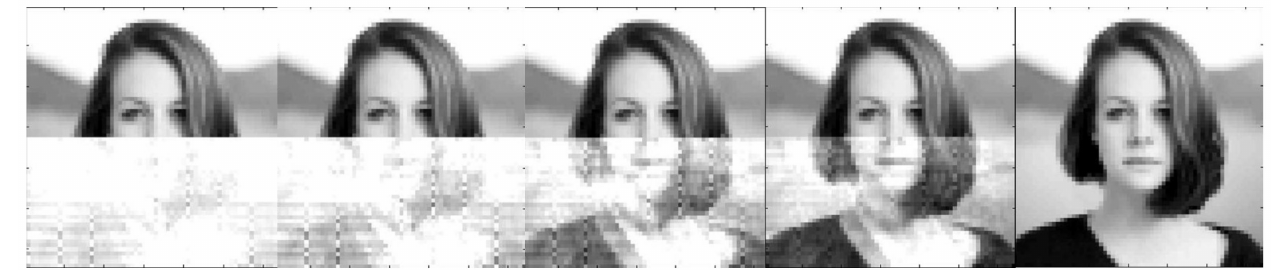
Figure 8. Image reconstruction process in Figure 6 (after 1, 2, 5, 10, and 100 iterations).